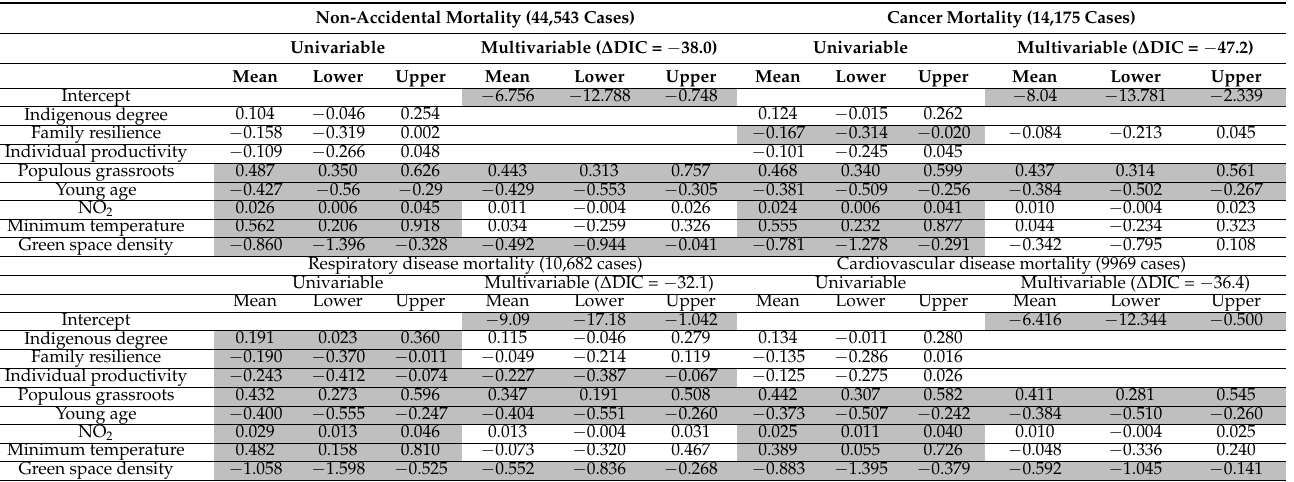
Table 2. Summary statistics for the posterior mean and 95% credible interval for the regression coefficients of the negative binomial regression models with respect to the four types of